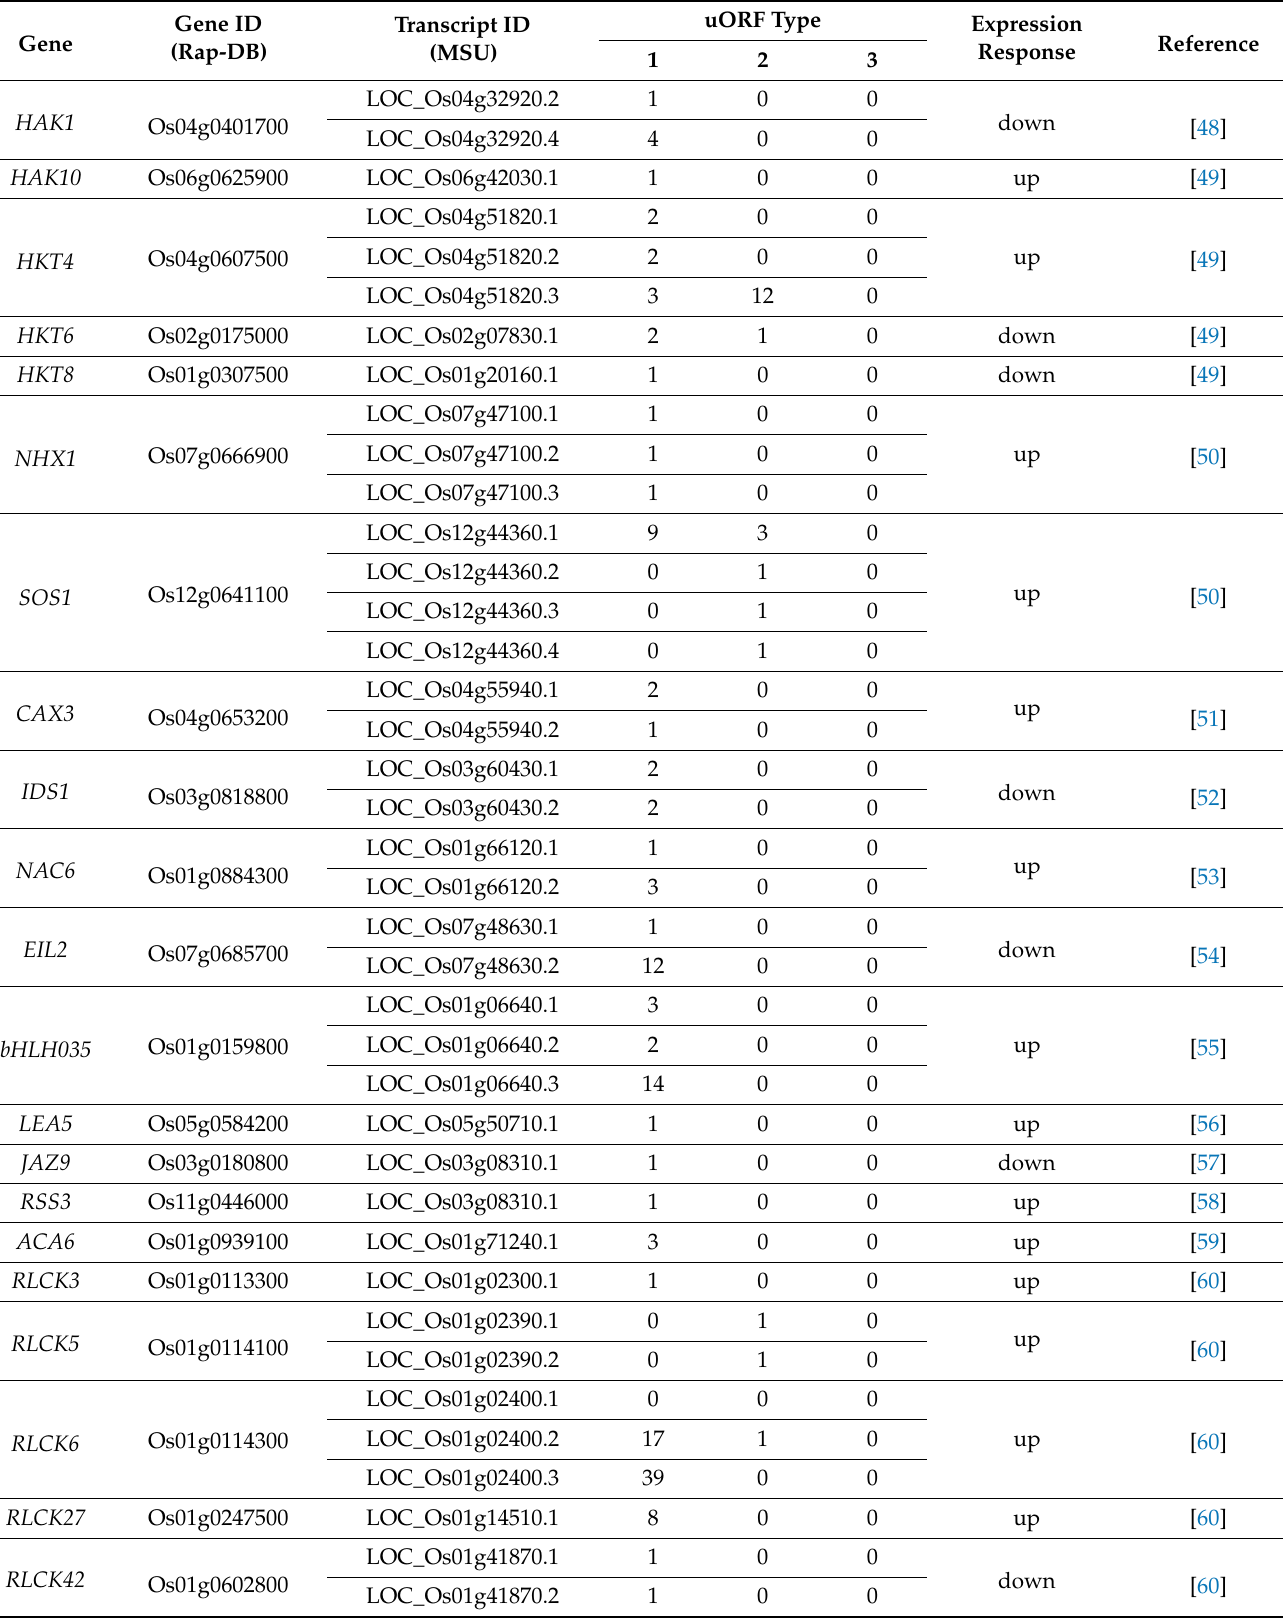
Table 1. Analysis of uORF in salt stress responsive